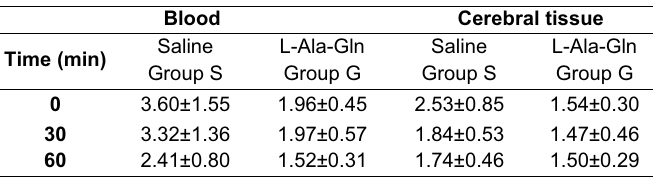
TABLE 2 - Lactate concentrations in blood (µmol/mL) and cerebral tissue (µmol/g) for Group S (saline solution) and Group G (L-alanyl-L- glutamine) before (T ) and after 30 minutes (T ) and 60 minutes (T ) 0 30 60 of reperfusion. Each value is based on a group of six animals.